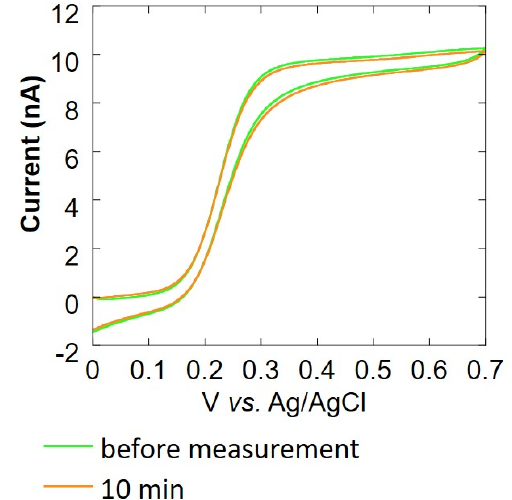
Figure 5. Evaluation of changes over time (in current value) by cyclic voltammetry upon collagen